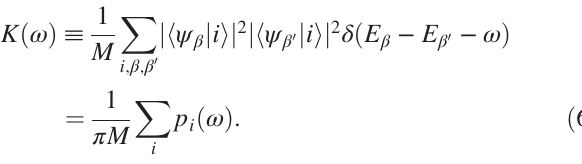
2 Σ 00 M ε and Γ is the typ typ ¼ typ ∝ V M 1 − γ = 2 ð log M Þ 1 = 2 typ typ